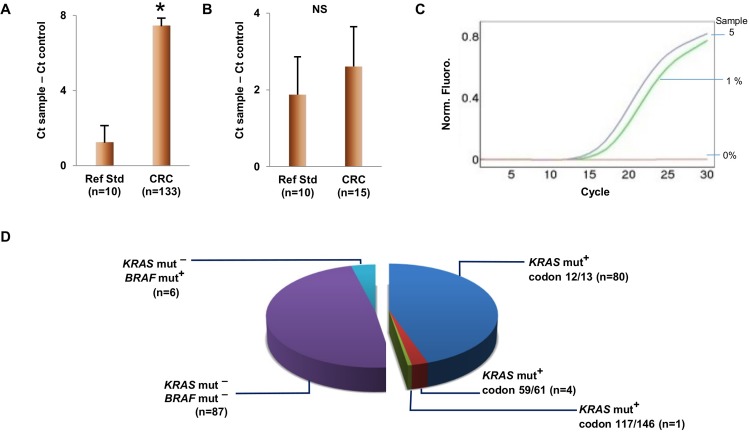
DNA sample quality and mutation status of study samples.A and B. Assessment of 200-bp (A) and 41-bp (B) amplifiable DNA in study samples. DNA samples isolated from cell line (control), FFPE reference standards and FFPE CRC tissues were evaluated. We included the control samples in every run to allow comparisons between runs. The amount of amplifiable DNA was compared to control by comparing the cycle thresholds (Ct) obtained from the quantitative PCR results. Error bars indicate the standard error of the mean. * = statistically significant t-test result (p< 0.01), NS = not statistically significant. Ref Std = FFPE reference standards, CRC = colorectal cancer tissue specimens, Ct = cycle threshold. C. Detection of BRAF mutation in poor-quality DNA obtained from FFPE CRC tissue (Sample 5 in Table 3). Genomic DNA sample from HEK-293 cells were used as negative control. D. KRAS and BRAF mutation status of 178 FFPE CRC tissues. The samples analyzed by methods other than cobas® KRAS Mutation Test, AmoyDx® KRAS Mutation Detection Kit and our AS-PCR assay were excluded from this study. mut- = mutation not detected, mut+ = mutation detected, ND = not determined.